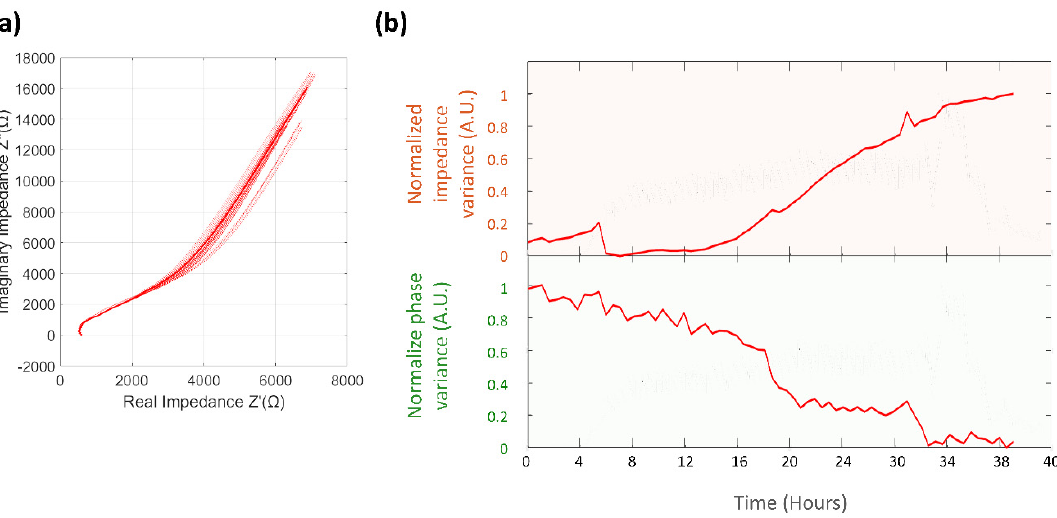
Figure 12. Analysis of impedance and phase variance for control experiment ( a ) EIS Nyquist plot of a control experiment, the solid line represents the mean value of EIS measurements, while the dotted lines are the actual values of the measurements during the ~37-hour control experiment. ( b ) Normalized impedance variance (Orange background) and normalized phase variance (Green background).